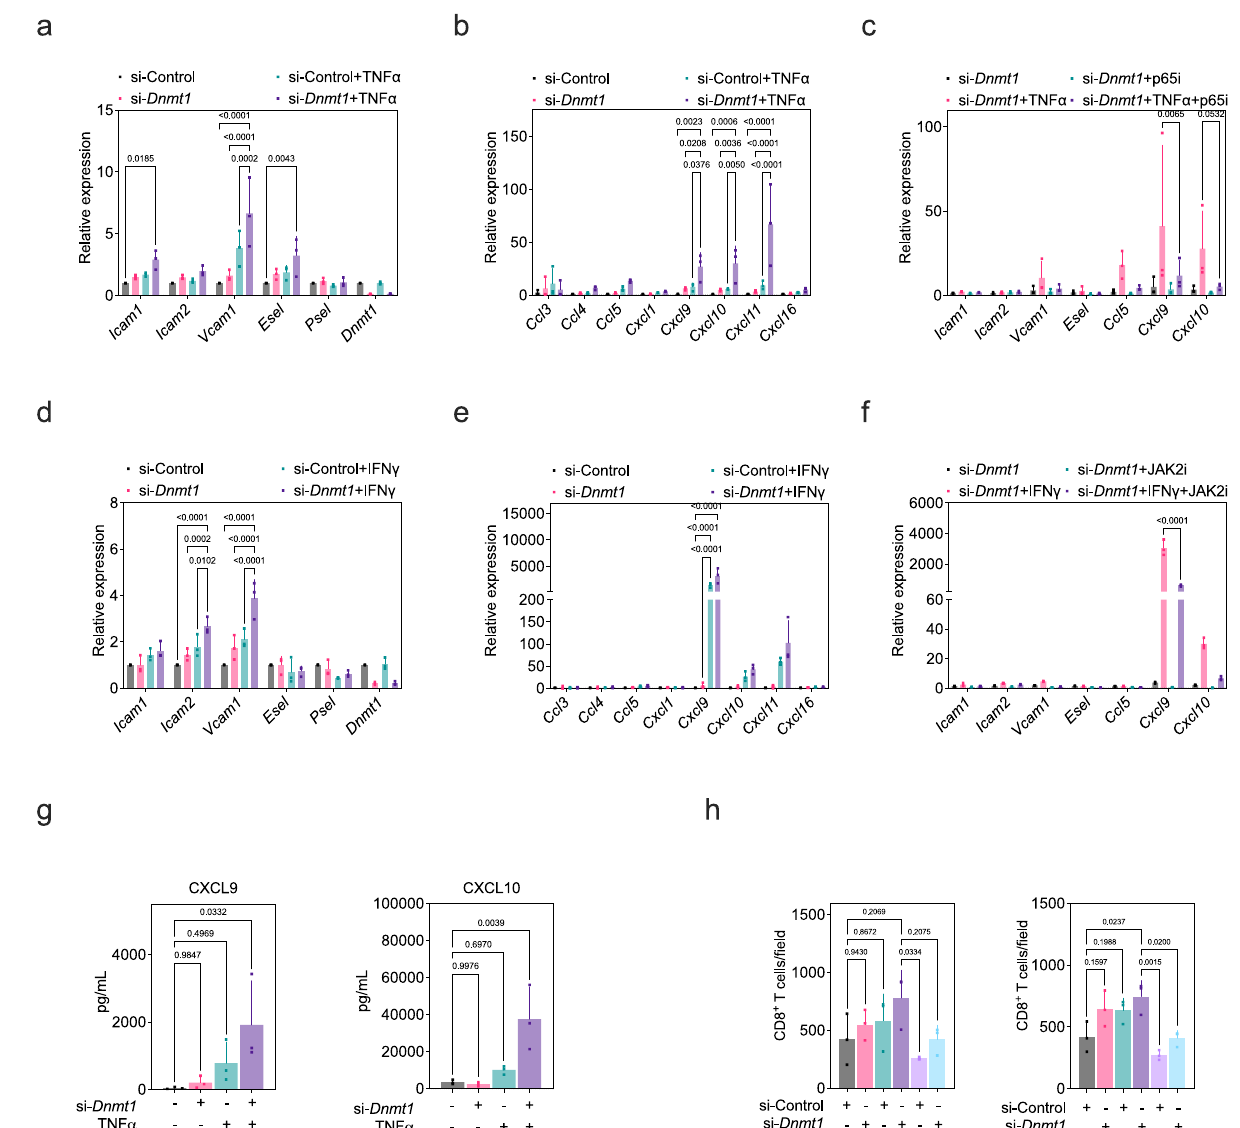
Fig. 2 | Targeting Dnmt1 in EC cultures potentiates a cytokine response that augmentsvascularcell:T-cellinteractions.a MGECsweretreatedwithscrambled controlor Dnmt1 siRNApriortochallengewithTNF α .SelectedCAMswereanalyzed by qPCR. b Same as in “ a ” except selected chemokines were analyzed by qPCR. c Same as in “ a , b ” except cellswerepre-treated with a p65 inhibitor prior to TNF α challenge. d MGECs were treated with scrambled control or Dnmt1 siRNA prior to challengewithIFN γ .SelectedCAMswereanalyzedbyqPCR. e Sameasin “ d ” except selected chemokines were analyzed by qPCR. f Same as in “ d , e ” except cells were pre-treated with a JAK2 inhibitor prior to IFN γ challenge. Each data point on the qPCR plots is the mean of n = 3 biological replicates run in triplicate. All qPCR